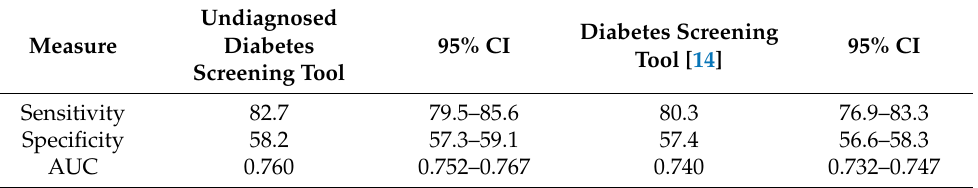
Table 3. Comparison of the newly developed undiagnosed diabetes screening tool and existing diabetes screening